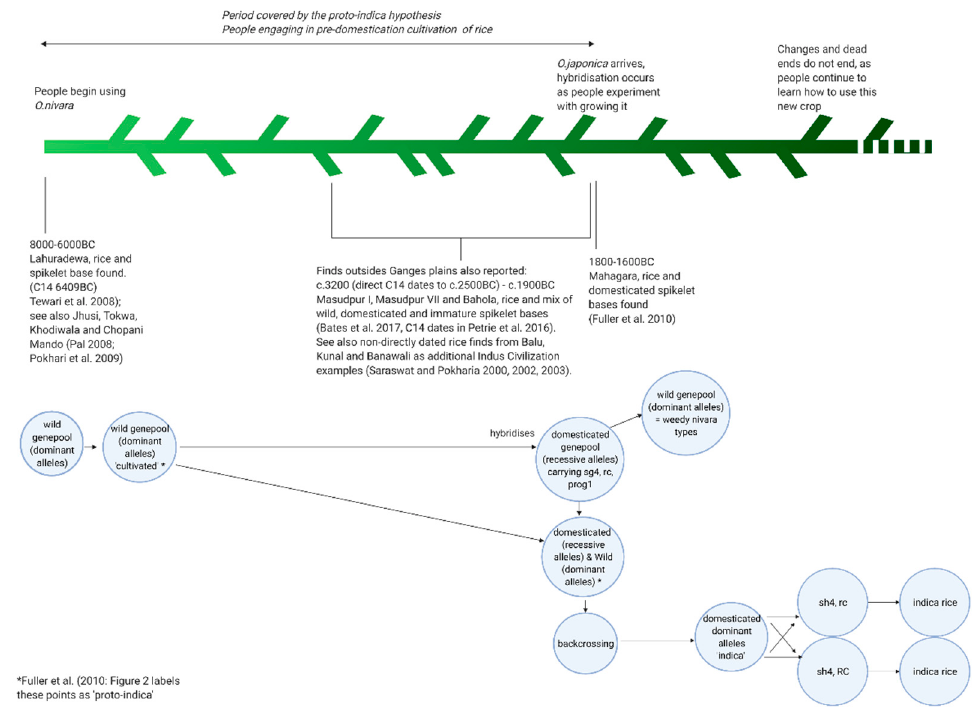
Figure 2. The complex pathways to rice domestication, schematized and oversimplified to place them in the archaeological context. At the start of the process, we have sites like Lahuradewa with evidence for human use of likely wild rice, and archaeogenetic evidence that suggests wild exploitation of nivara, at the other end we have sites like Mahagara where the spikelet bases show domesticated rice use, and the (archaeo)genetics suggests the hybridization was if not complete then certainly under way. At what point in between these does nivara become another species? Does it indeed become another species? The dead ends seen (archaeo)genetically and in the increasing evidence for domesticated spikelet bases found alongside wild types suggests some changes were occurring before hybridization—should these be given the almost species-like name ‘proto-indica’? The determinism behind this epithet—that these will become, are becoming, indica is problematic due to the hindsight placed upon them by us, and the dead ends we see in the genetic data. Or instead is proto-indica perhaps another name for the human processes behind the changes occurring, for pre-domestication cultivation? Genetics taken from Fuller et al. ([56]: Figure 2), and the original archaeobotanical data for Masudpur I, Masudpur VII, and Bahola can be found in [63]. [Created with BioRender.com, under a CC BY license, with permission from Biorender, original copyright 2020.].